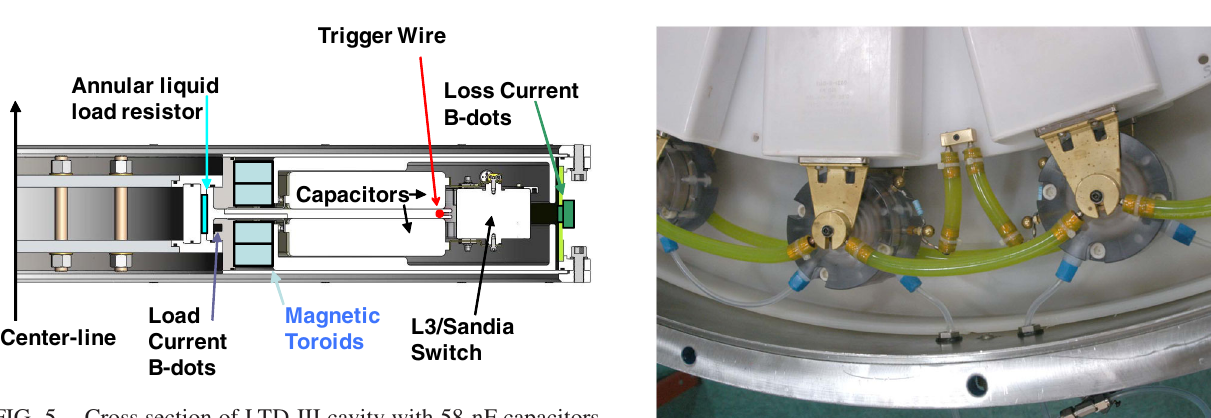
FIG. 5. Cross section of LTD-III cavity with 58-nF capacitors, showing location of capacitors, switches, magnetic toroids, and annular KBr resistive load along with load and loss current B-dot monitors.